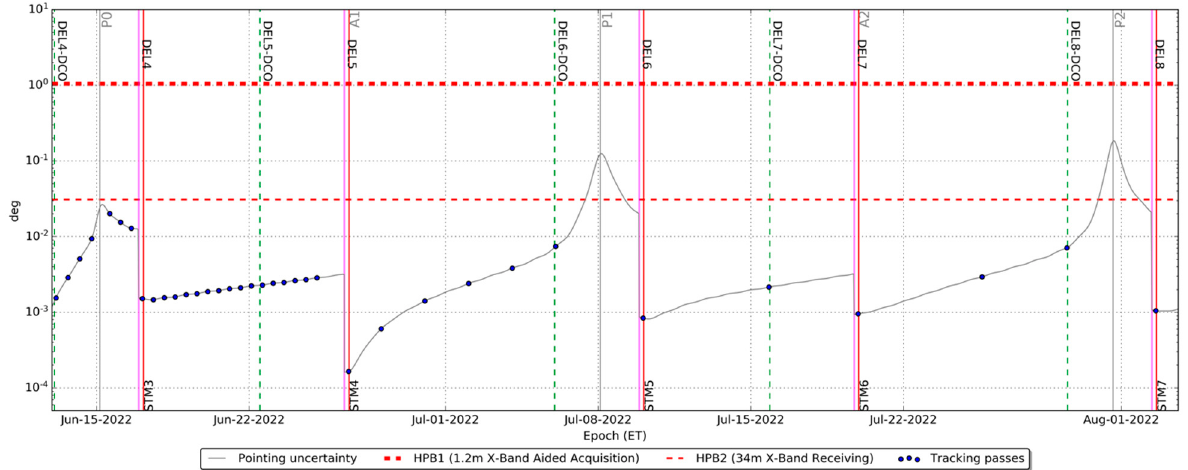
Figure 11. DSN to ArgoMoon pointing uncertainty evolution (3-sigma) from P0 to P2 (encompasses REV1 and REV2). The gray line is the uncertainty evolution with the nominal delivery schedule, while the blue dots identify the tracking passes.